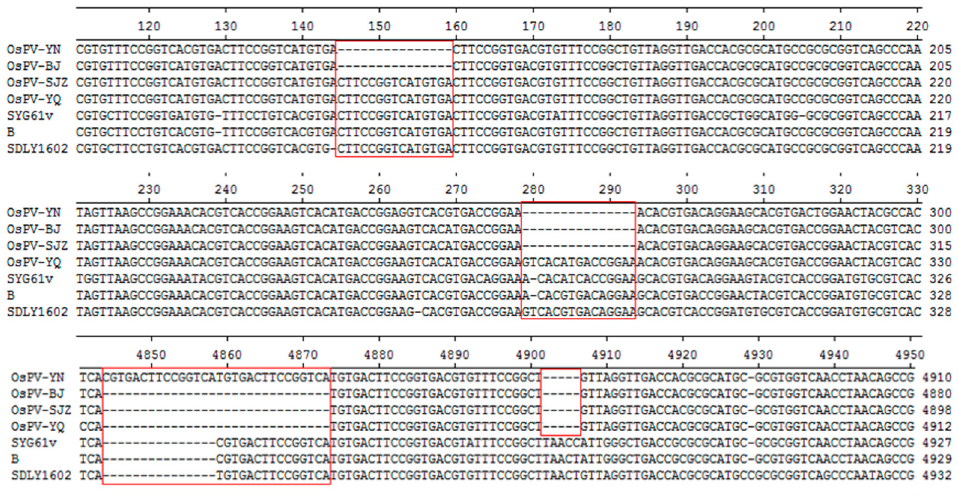
Figure 1. Sequence alignments of the inverted terminal repeats (ITRs) of the OsPVs, GPVs (goose parvovirus strains SYG61v and B) and NGPV (novel goose parvovirus related virus strain